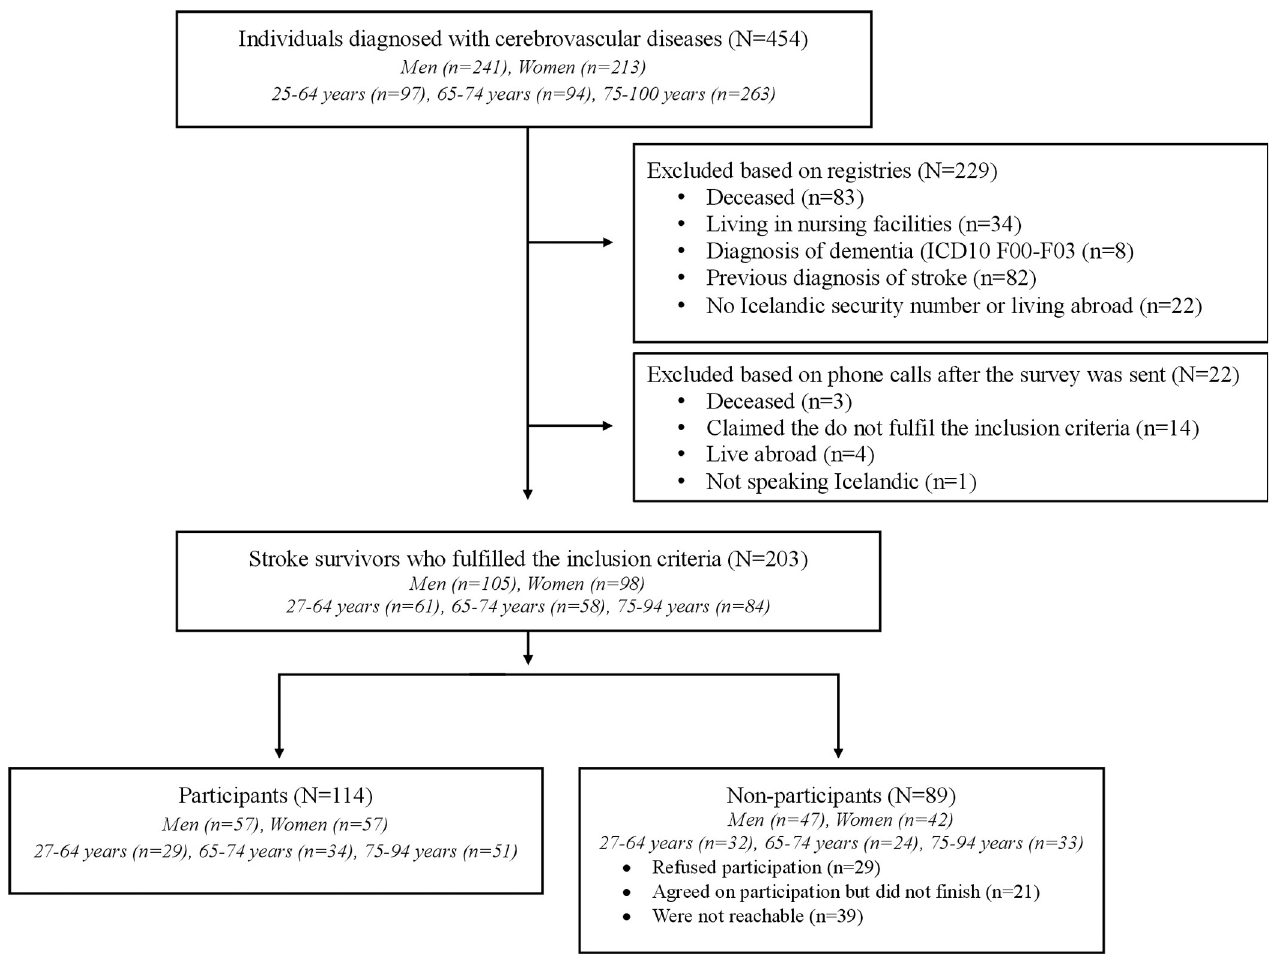
Fig 2. Flowchart of inclusion of